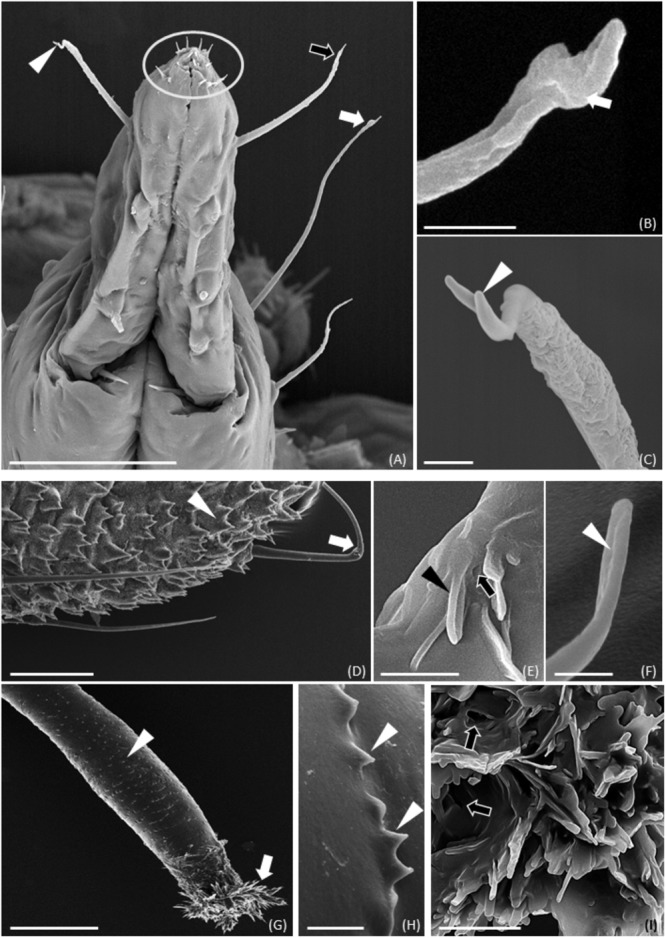
SEM images showing sensilla on M. viciae mouthparts, cauda and cornicles. (A) Long sensilla symmetrically distributed (arrowhead) and short sensilla (encircled) situated on the labium tip. (B) Detail of long sensilla tip with pre-apical expansion (black arrow in (A)) or in the shape of a cup (arrow in (A,B)). (C) Detail of long sensilla branched tip (arrowhead). (D–F) Detail of porous (arrow in (E)) or fissure like structures (arrowheads in (E,F)) on long sensilla and finger-like extensions (arrowhead in (D)) on M. viciae cauda. Finally, SEM observation highlights the presence of cuticular finger-like structures (arrowheads in (G,H)) on cornicle surface. Moreover, hole-like structures are evident among cuticular tufts (arrows in (I)) of cornicle terminal region. Bar in (A), 50 μm; bars in (B,E,F), 1 μm; bar in (C), 2 μm; bar in (D), 25 μm; bar in (G), 100 μm; bars in (H,I), 5 μm.